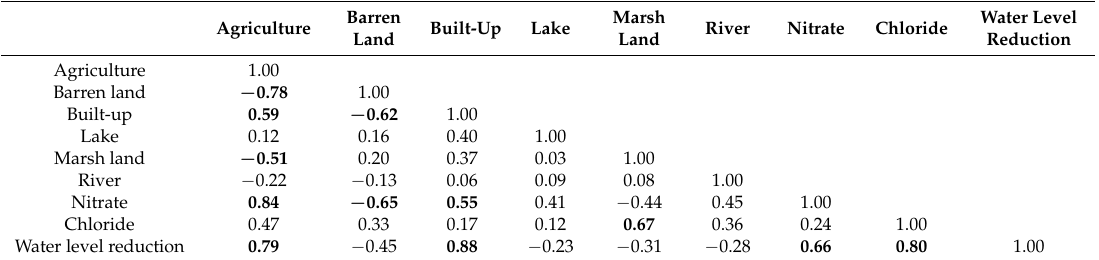
Table 4. Correlation matrix showing relationship change in LULC and water quality parameters from 2001 to